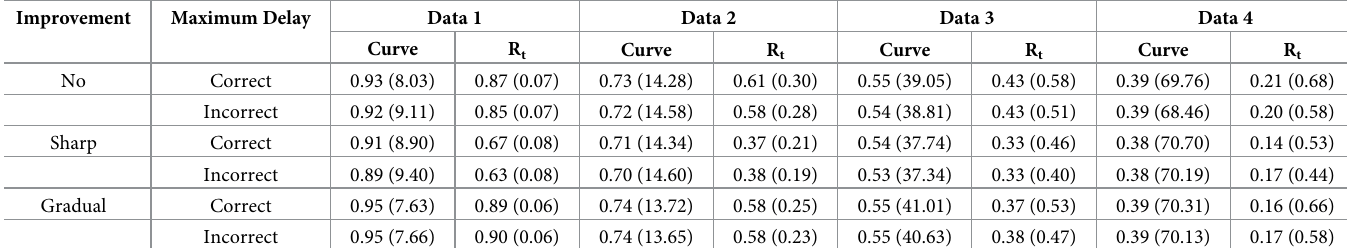
Table 2. Performance measures for data with no early report. The results were averaged over all simulated datasets and dates for both the epidemic curve (Curve) and the reproduction numbers (